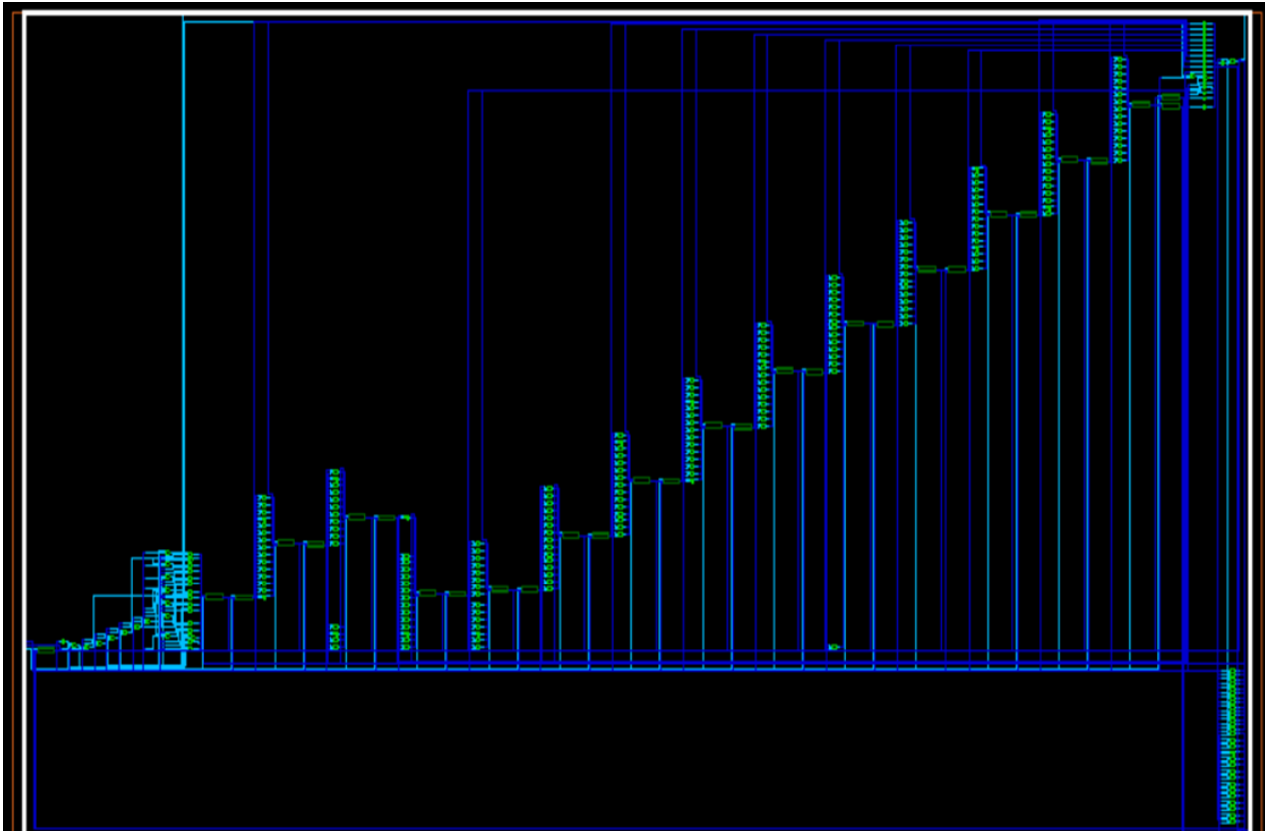
Figure 12. Circuit for the 16-bit non-restoring divider generated through